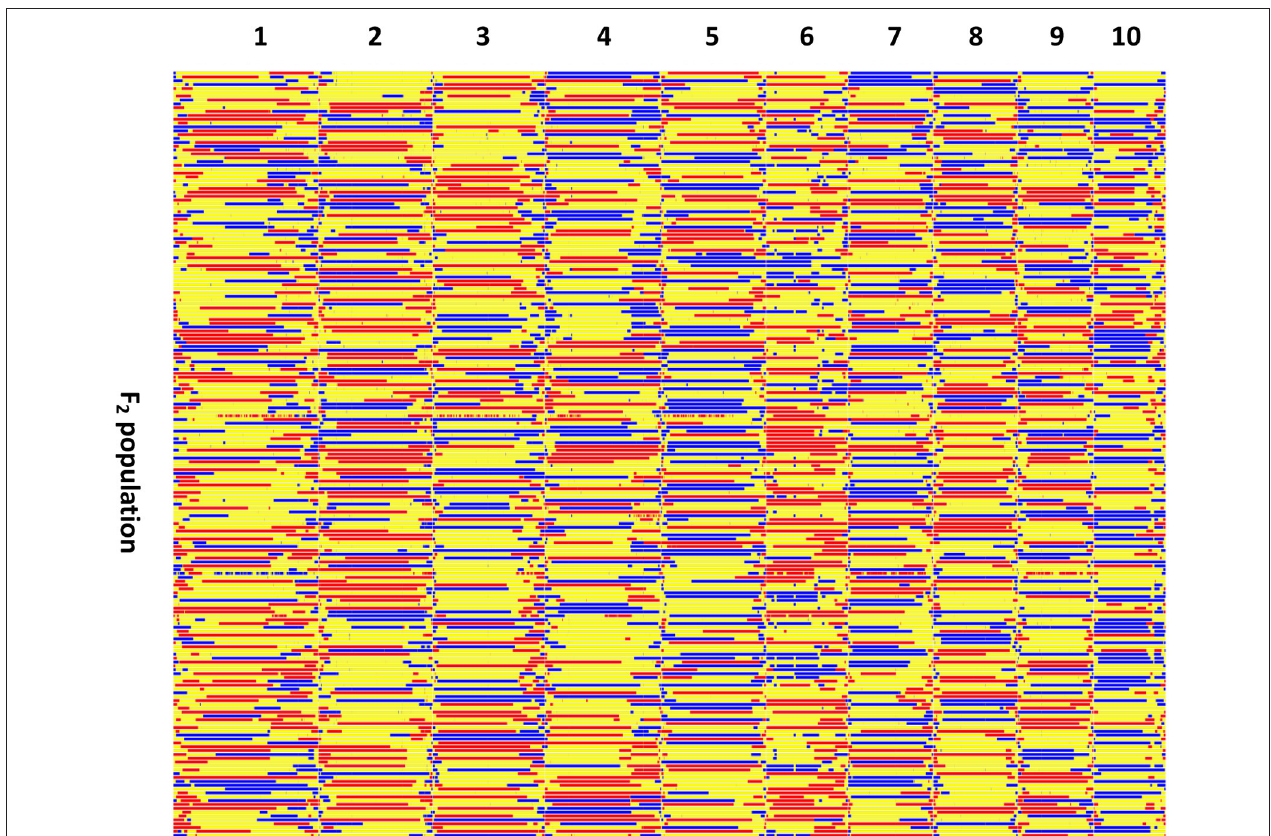
FIGURE 3 | Recombination bin-map of the F 2 population. Bin-map consists of 3,305 bin markers inferred from 29,927 high quality SNPs in the F 2 population. Physical position is based on the Zea_mays.AGPv3.29 sequence. Red, SG5 genotype; Blue, SG7 genotype; Yellow, heterozygote.